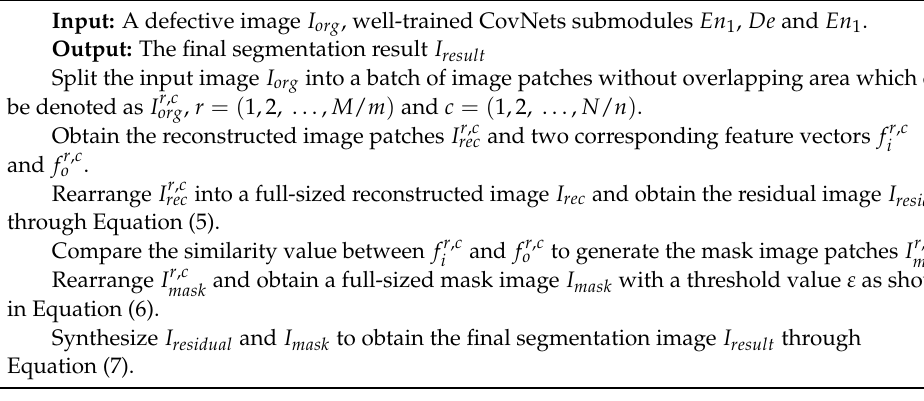
Algorithm 1. The defect detection and segmentation.